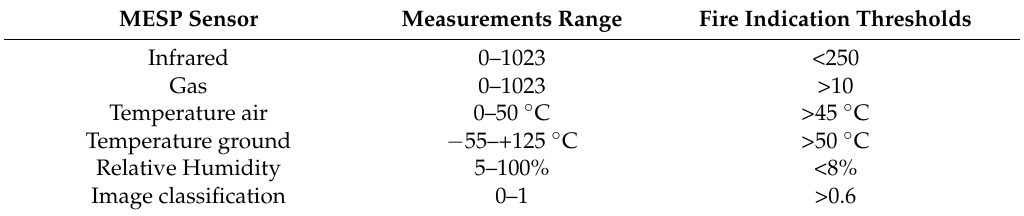
Table 3. Sensor measurements range and fire